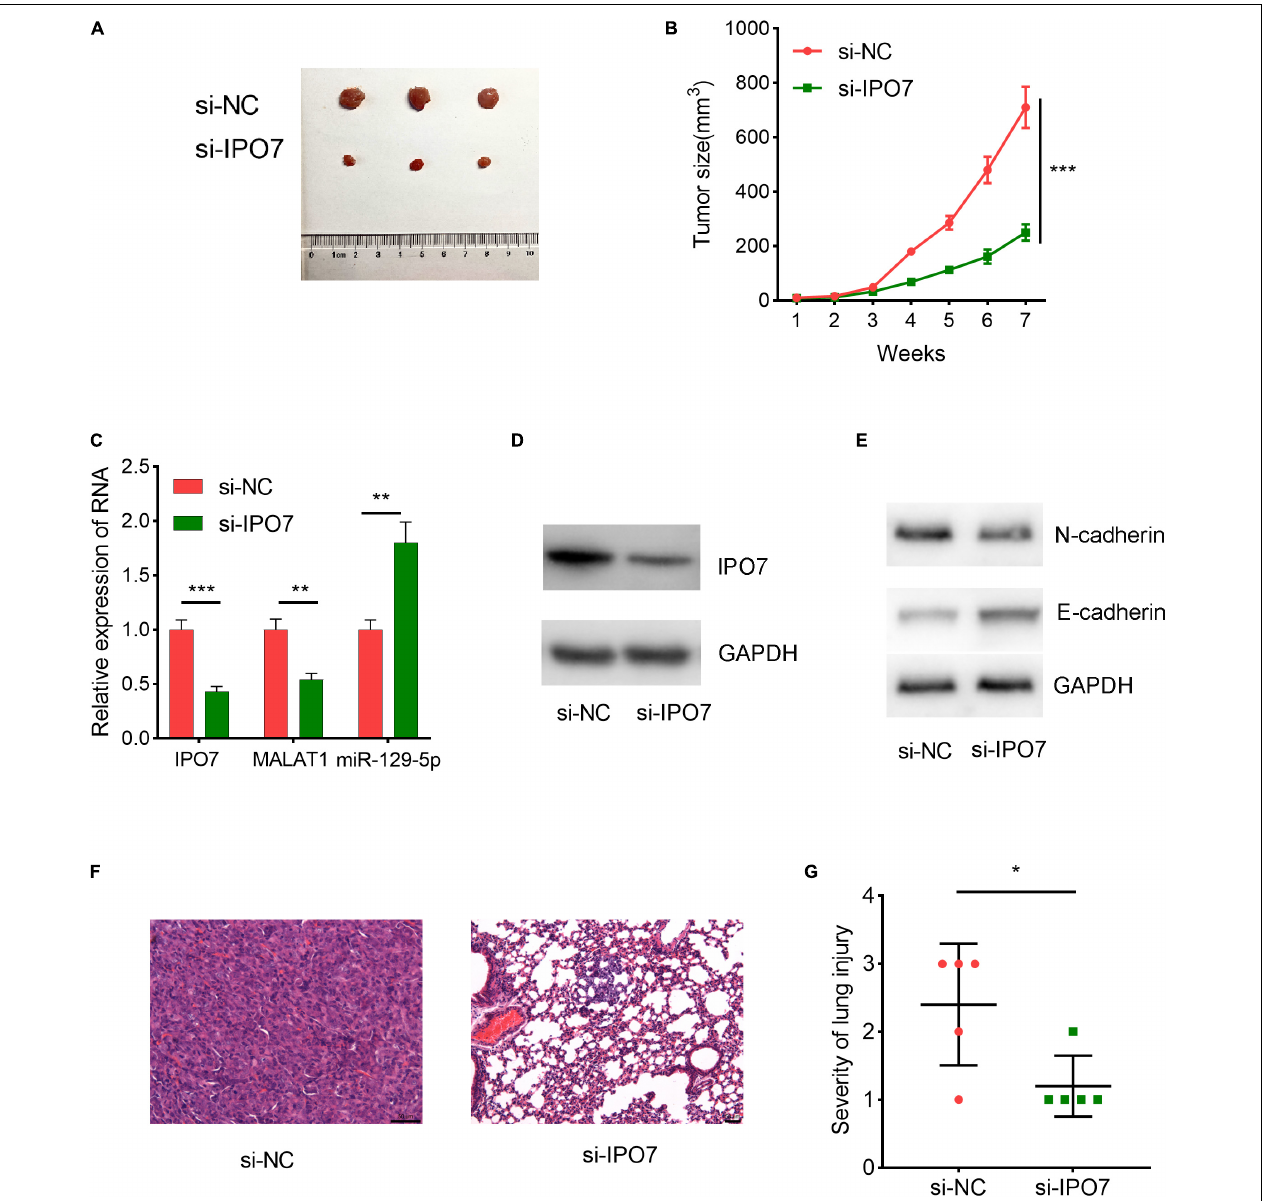
FIGURE 9 | Importin 7 (IPO7) knockdown can restrain the growth and metastasis of pancreatic cancer cells in vivo . (A,B) IPO7 depletion reduced the tumor size in vivo. (C) The expression of IPO7, metastasis-associated lung adenocarcinoma transcript 1 (MALAT1), and miR-129-5p in tumor tissues of the mice was determined by qPCR. (D,E) The expression of E-cadherin and N-cadherin in tumor tissues of the mice was determined by Western blot. (F) Representative hematoxylin and eosin staining images of the lung metastasis of the mice. (G) Chi-square test was used to analyze the difference in the degree of lung metastasis between the two groups (3, severe; 2, moderate; 1, mild). * p < 0.05, ** p < 0.01, *** p <